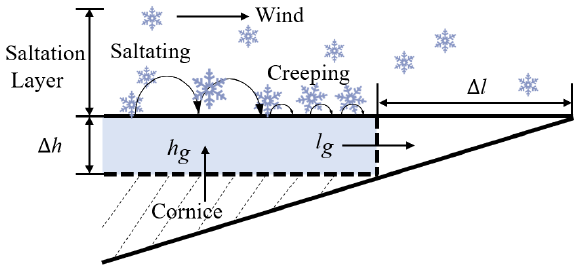
Figure 7. Schematic of snow cornice